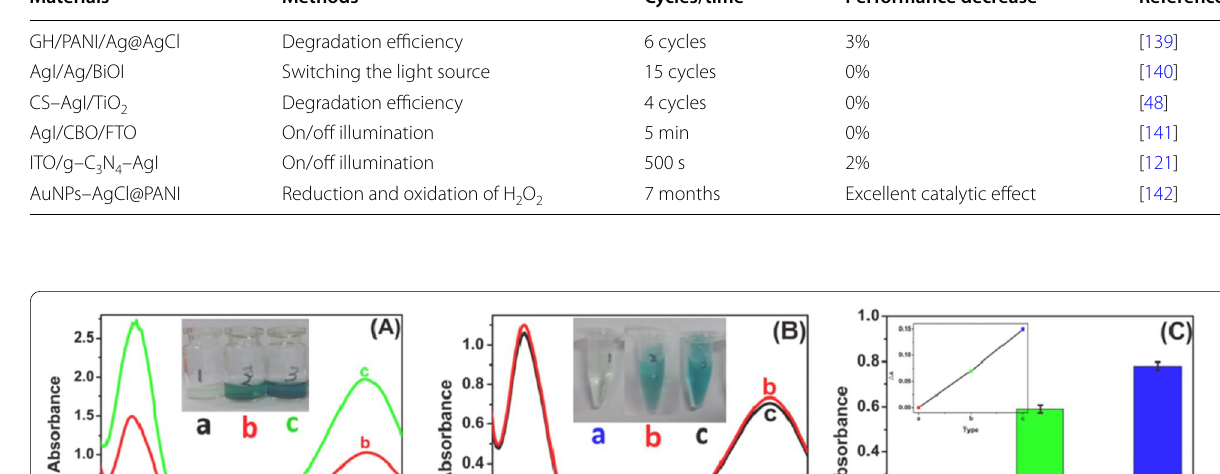
Table 1 The stability of Ag/AgX biosensors Materials